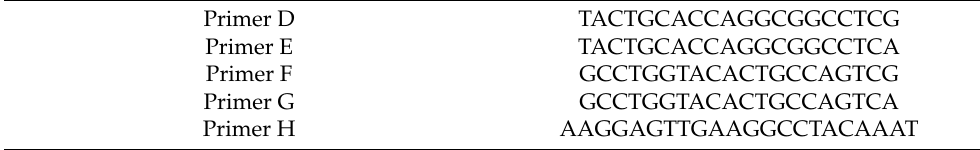
Table 6. Oligonucleotide primer sequences: primer sequence ( 5 (cid:48) –3 (cid:48) ). Primers D and E are similar; their differences are shown below; the same goes for primer F and G. Primer H is the common primer. Primer D